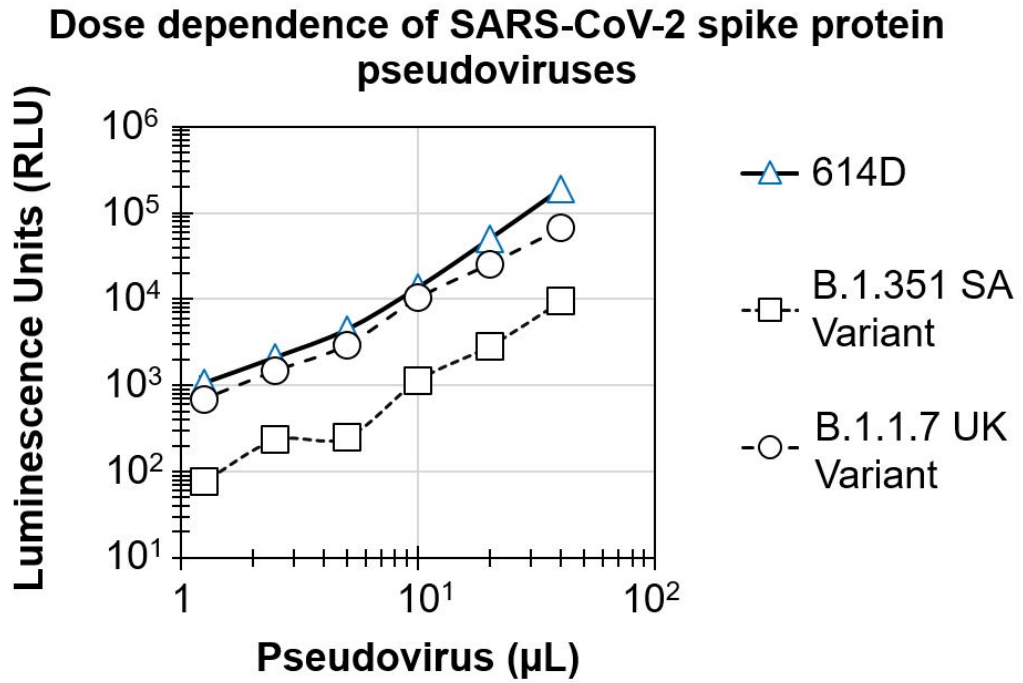
Figure 1. Dose dependence of SARS-CoV-2 spike protein pseudoviruses: HEK293T-hACE2 cells seeded in 96-well plates were infected with increasing concentrations of SARS-CoV-2 spike protein pseudoviruses. Intracellular luciferase signal (as a marker of spike protein-mediated pseudovirus infection) measured at the end of 3 days is shown on the Y -axis. Triangles–614D variant, Circles–B.1.1.7 UK variant, squares boxes–B.1.351 SA